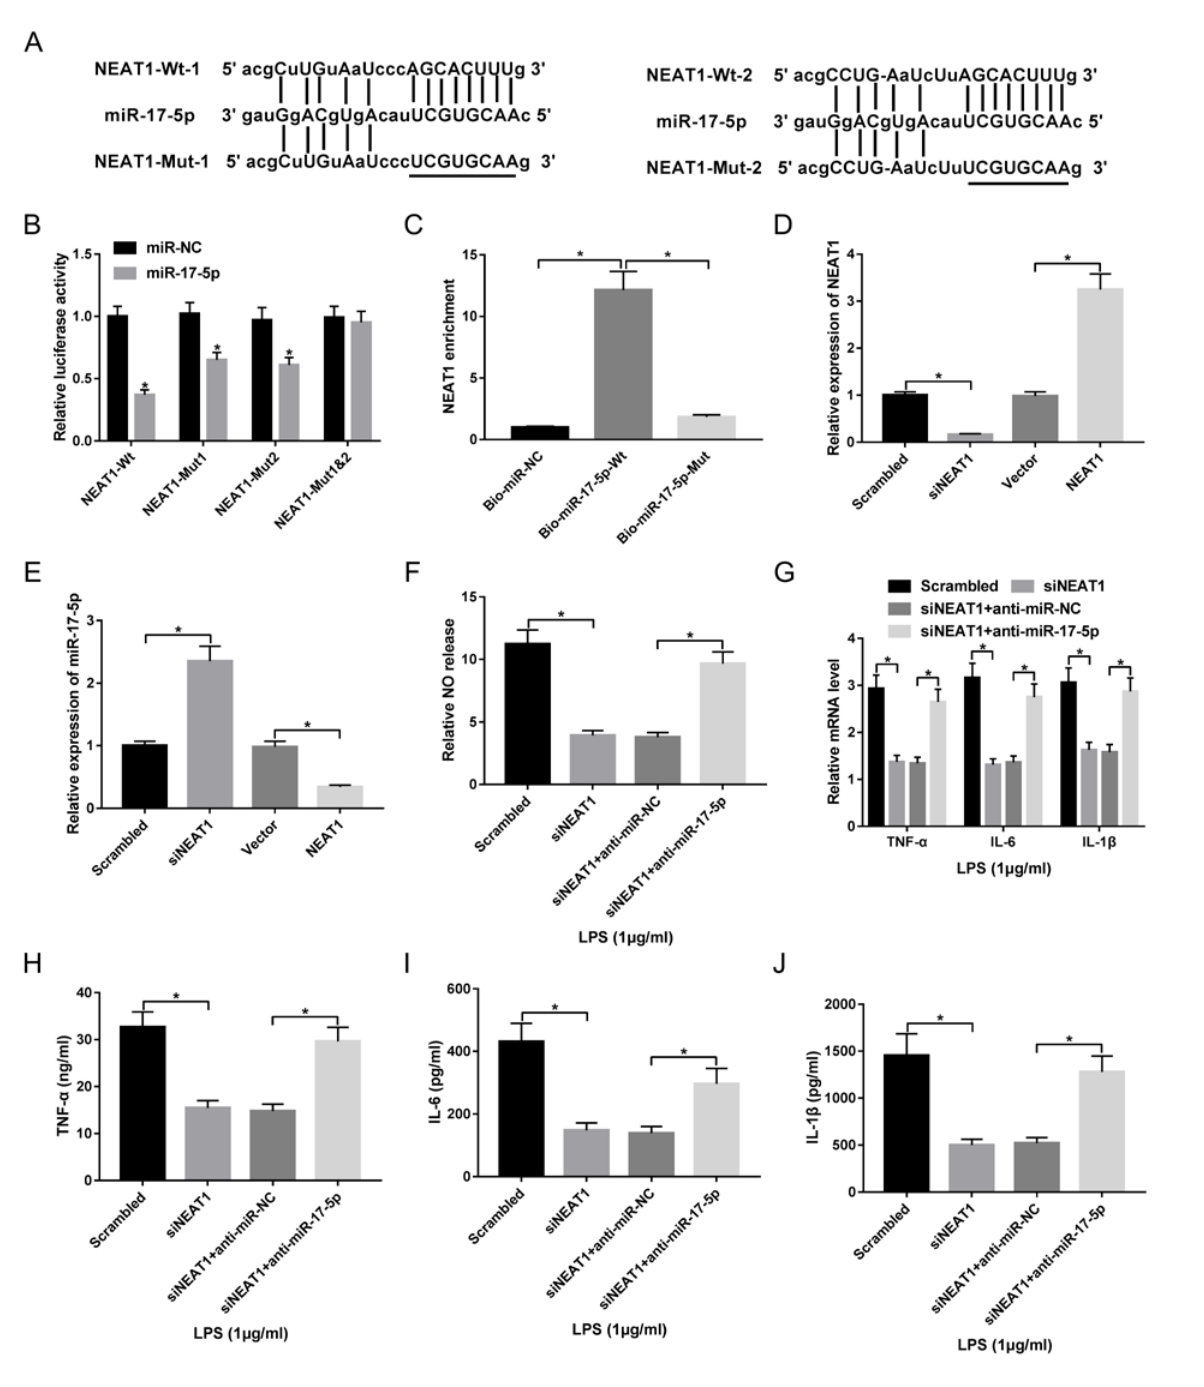
Figure 3: NEAT1 knockdown suppresses LPS-induced inflammatory injury by targeting miR-17-5p in macrophages. (A) The potential binding sites of NEAT1 and miR-17-5p. (B) Luciferase activity was detected in macrophages co-transfected with miR-17-5p or miR-NC and NEAT1-Wt or NEAT1-Mut. (C) The enrichment of NEAT1 was detected in macrophages by RNA pull-down. (D and E) The expressions of NEAT1 and miR-17-5p were detected in macrophages transfected with scrambled, siNEAT1, vector or NEAT1. (F-J) NO release and inflammatory cytokines levels were measured in macrophages transfected with scrambled, siNEAT1, siNEAT1 and anti-miR-NC or anti-miR-17-5p.